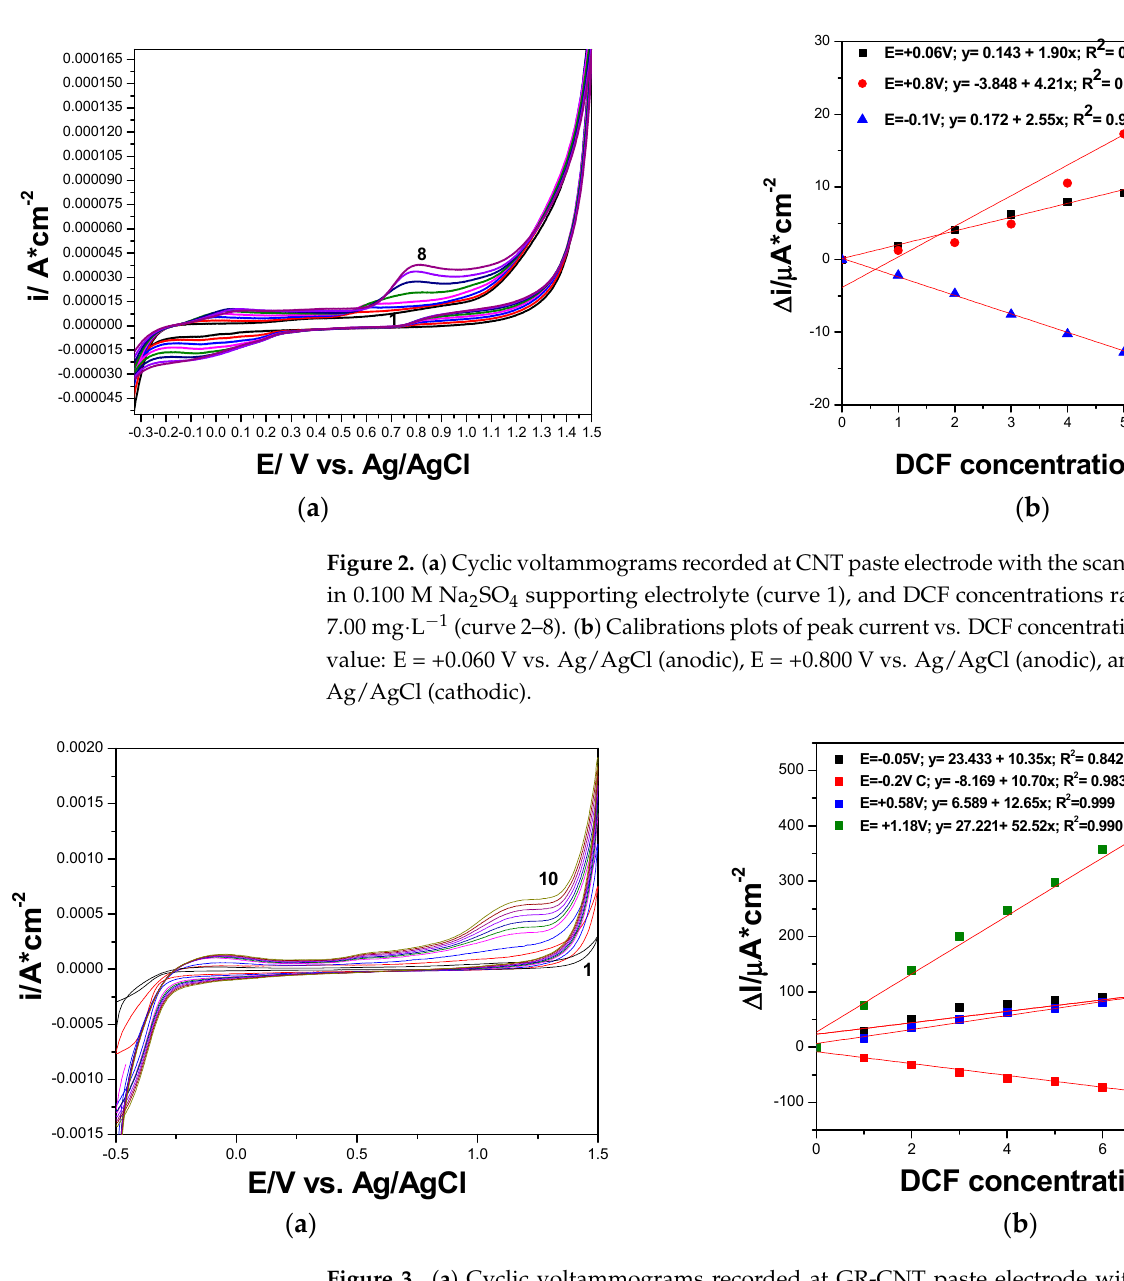
Figure 3. ( a ) Cyclic voltammograms recorded at GR-CNT paste electrode with the scan rate of 0.050 V · s − 1 in 0.100 M Na 2 SO 4 supporting electrolyte (curve 1), and DCF concentrations ranged from 1.00 to 9.00 mg · L − 1 (curve 2–10). ( b ) Calibrations plots of peak current vs. DCF concentrations at the potential value: E = − 0.050 V vs. Ag/AgCl (anodic), E = +0.580 V vs. Ag/AgCl (anodic), E = +1.180 V vs. Ag/AgCl (anodic), and E = − 0.200 V vs. Ag/AgCl (cathodic). An overview of results regarding the sensitivities and the detection potentials of DCF on both CNT and GR-CNT paste electrodes are gathered in Table